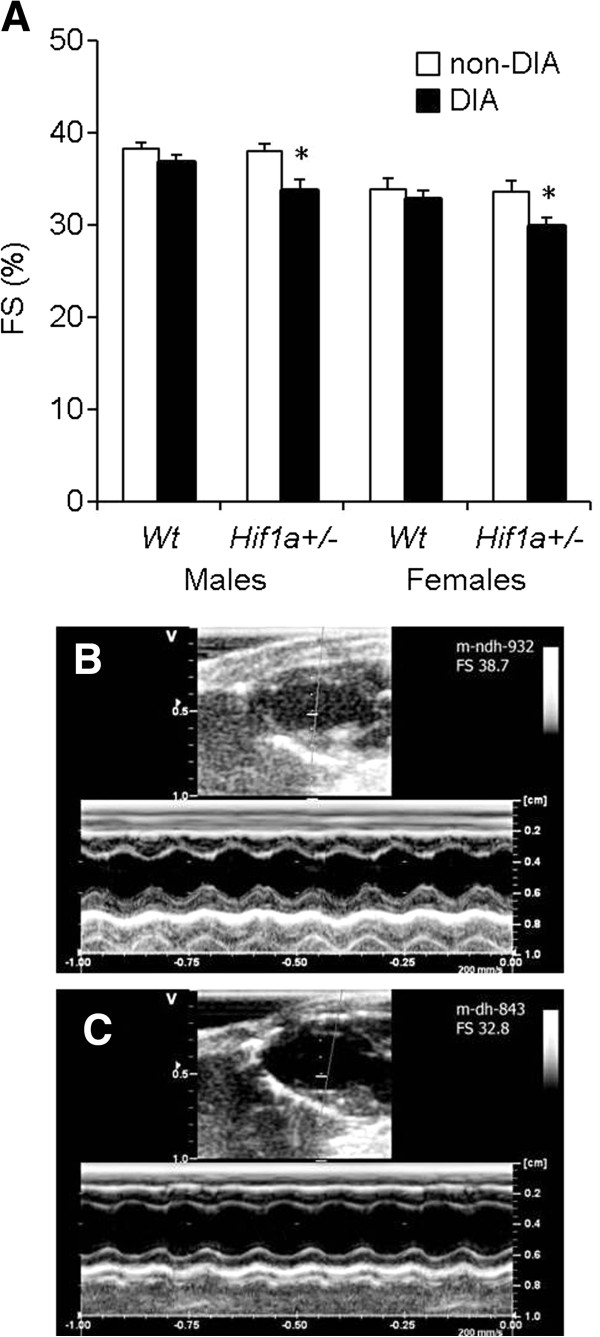
Echocardiographic assessment of LV systolic function in Wt and Hif1a+/-mice. (A) The exposure to the diabetic environment resulted in a significant decrease of LV fractional shortening (FS) in Hif1a+/- mice but not in Wt animals. The values are mean ± SEM, statistical significance by 2-way ANOVA with Tukey’s multiple-comparison test, *P < 0.05, diabetic Hif1a+/-vs. Wt and Hif1a+/- non-diabetics. Representative M-mode recordings of LV structures in long axes view in a non-diabetic (B) and diabetic (C)Hif1a+/- mouse with FS = 38.7 and FS = 32.8, respectively.